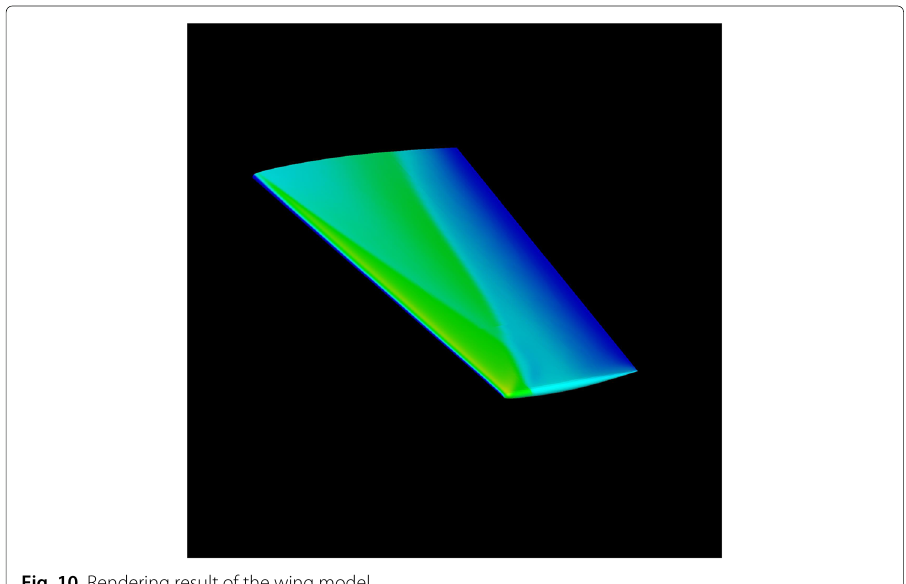
Fig. 10 Rendering result of the wing